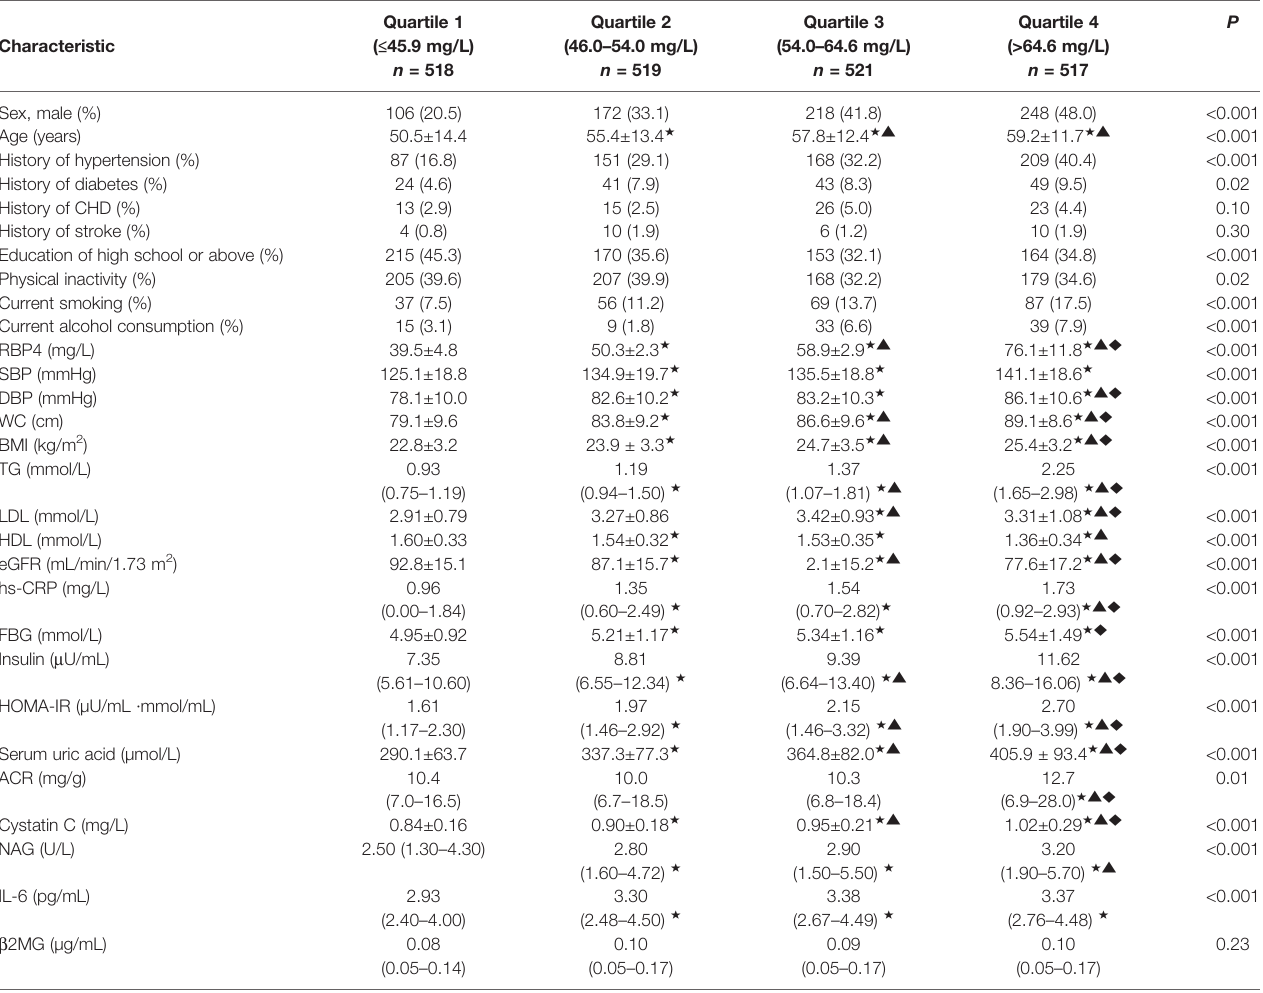
TABLE 2 | Participant baseline characteristics by RBP4 quartile.